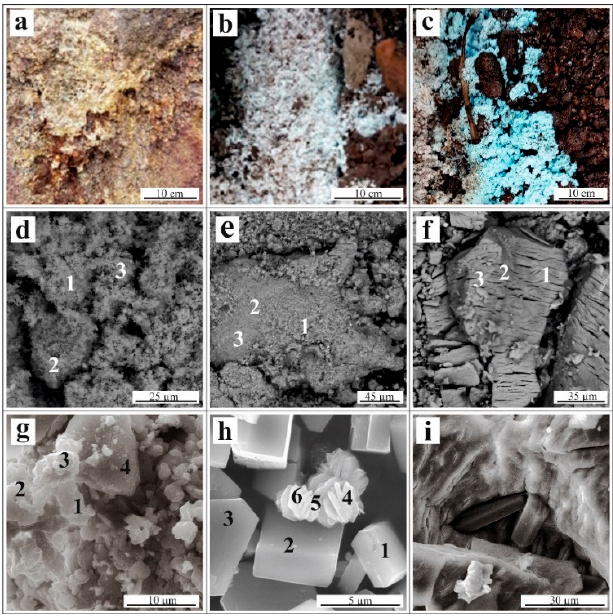
Figure 2. ( A – C ) Occurrence of e ffl orescences on the waste surface; ( D – I ) Scanning electron microscope images: ( D )—fine-grained mass of Na-jarosite; ( E )—melanterite with an admixture of Cu and Zn; ( F )—chalcanthite (CuSO 4 · 5H 2 O); ( G )—unformed grains of namuwite (Cu,Zn) 4 SO 4 (OH) 4 · 4H 2 O; ( H )—needle-like crystals of linarite (PbCu[SO 4 ](OH) 2 ) associated with short-prismatic crystals of antlerite (Cu 3 (SO 4 )(OH) 4 ); and ( I )—prismatic crystals of gypsum (CaSO 4 · 2H 2 O) associated with chalcanthite. The numbers in images ( D – I ) correspond to the locations of the energy dispersive X-ray microanalysis (Table 1).